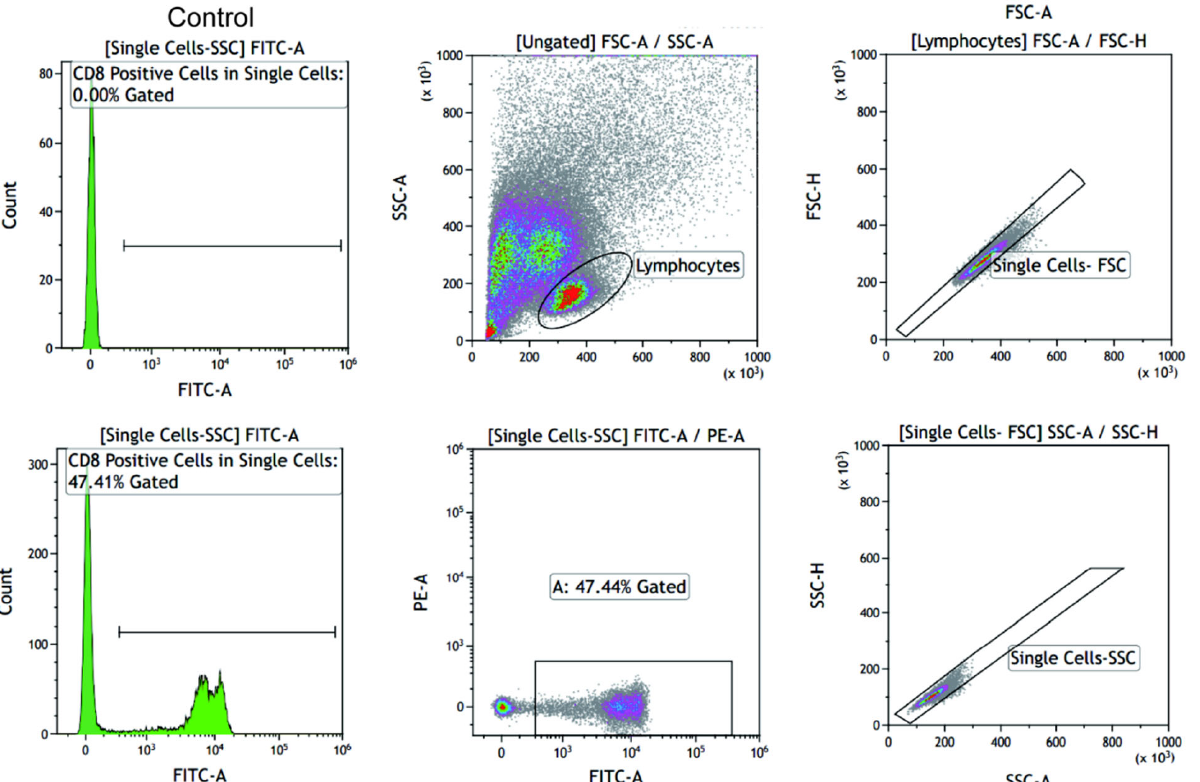
Figure 8. CoraLite ® 488 Anti-Human CD8 (SK1) antibody was used to perform fluorescence-activated cell sorting (Automatic Flow Cytometer MA900, Sony, Tokyo, Japan) in Group N.